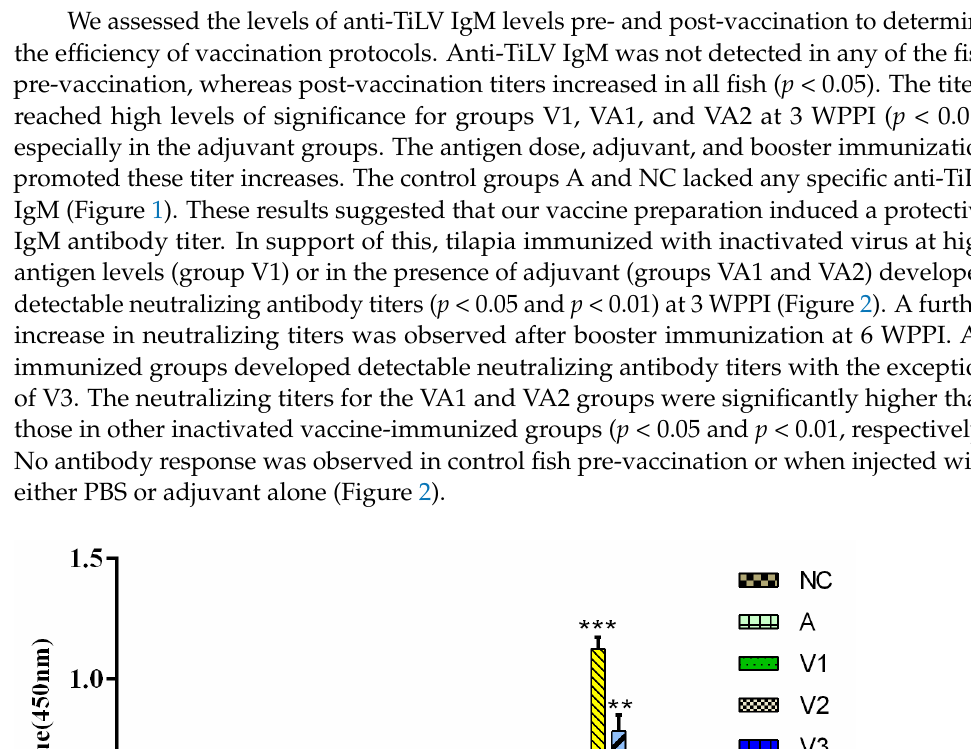
Figure 2. Detection of TiLV-specific serum neutralizing antibodies induced in the vaccinated tilapia: five serum samples from each group collected pre-vaccination (PV) and at three and six weeks post primary immunization (WPPI) were tested by the serum neutralization test to determine the anti- body titers against the virulent isolates TiLV 2017A. A comparison between the vaccinated groups